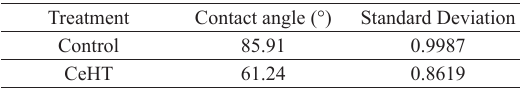
Figure 7. AFM micrographs of AA1230 clad on AA2024 alloy. (A) 3D of Control surface, (B) 3D CeHT treated surface. (C) 2D of Control surface (D) 2D of CeHT treated Table 1. Results of contact angle measurements.